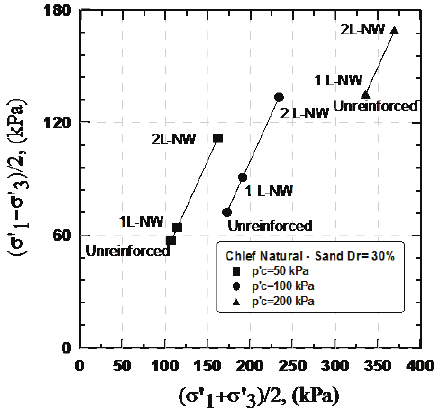
Fig. 11. (  1 –  3  versus (  1 –  3  envelopes plot of geotextile reinforced samples at the end of tests (18% axial strain)